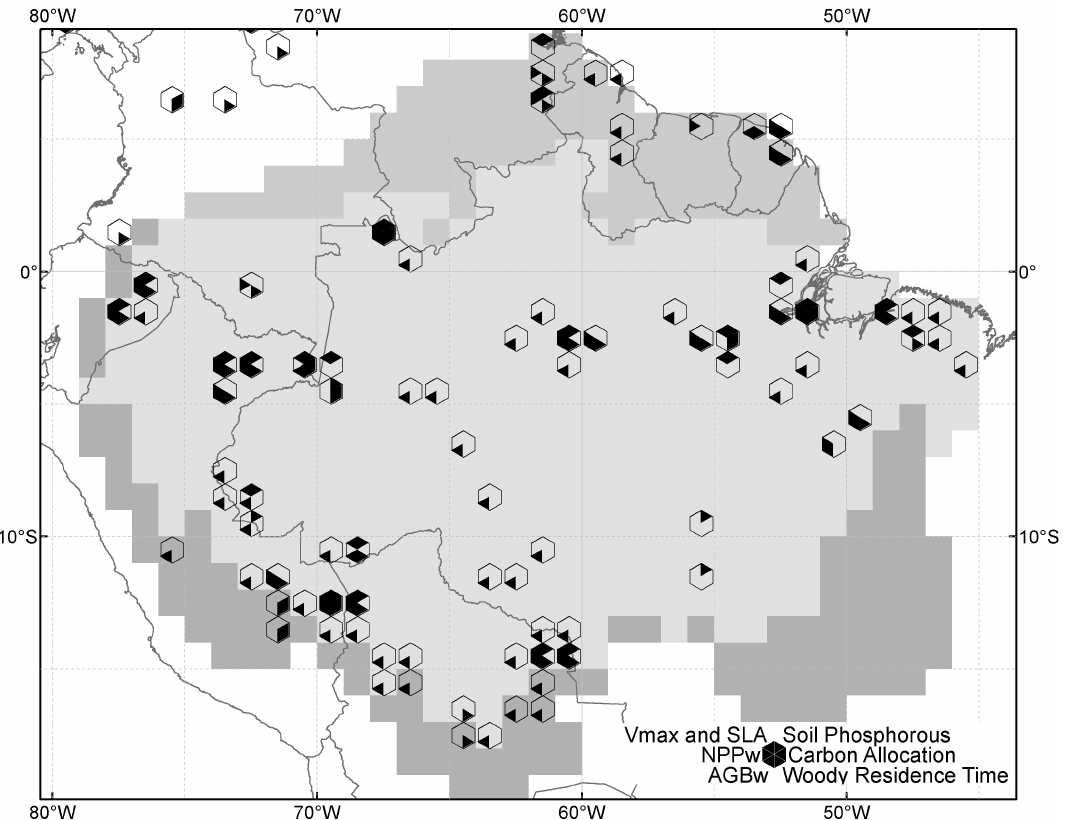
Fig. 1. Locations of the main field observation data: woody above-ground biomass (Malhi et al., 2006); woody net primary productivity (Malhi et al., 2004); maximum carboxylation capacity of RuBisCO and specific leaf area index (Fyllas et al., 2009); total soil Pposphorus (Quesada et al., 2010); woody carbon allocation (Malhi et al., 2011); woody residence time (Galbraith et al., 2013). Shaded areas include the Amazonian sensu stricto (Amazon basin below 700ma.s.l., light gray) with an estimated area of ∼ 5.65millionkm 2 , Amazon River basin (light gray including southeast Planalto, western Andes in dark gray) and tropical forest areas in the north (Guiana, dark gray) (Eva et al., 2005). Each field site that provided data is marked by a hexagon, which is divided into 6 wedges. Each wedge corresponds to a particular variable (see key in lower right). If a particular field variable is available at a site, the wedge corresponding to it is black. For example if woody above-ground biomass (AGB w ) was collected at a particular site, the lower left wedge is